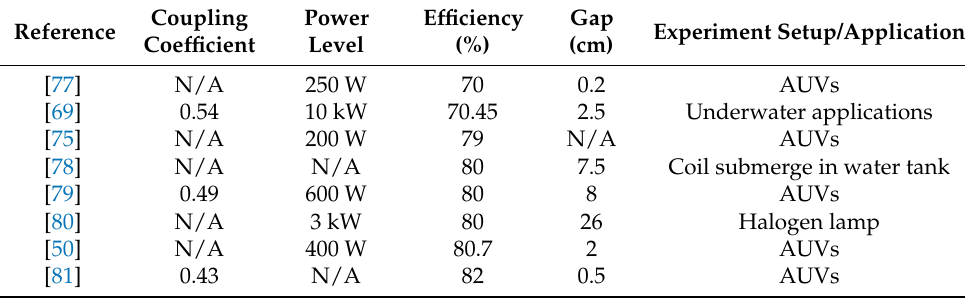
Table 3. Research work in